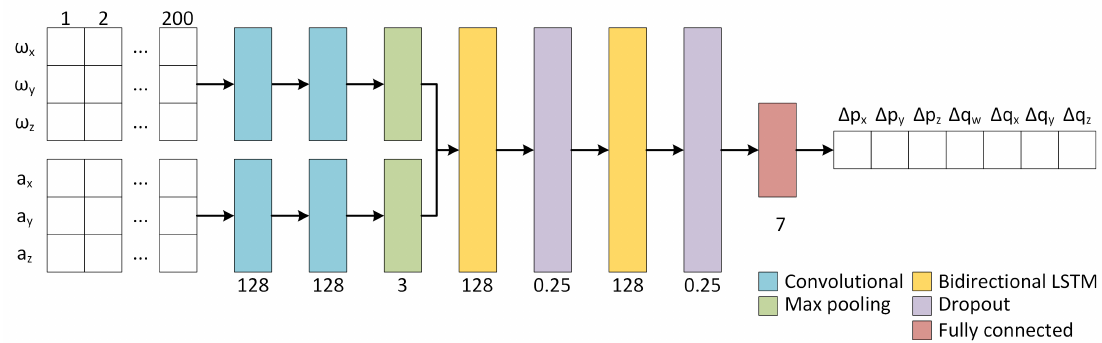
Figure 1. Network architecture for 6-DOF inertial odometry. The number of features is shown below the convolutional layers, the pool size is shown below the max pooling layers, the number of units is shown below LSTM and fully connected layers, and the dropout rate is shown below the dropout layers. The example output uses the 3D translation vector and unit quaternion based relative pose